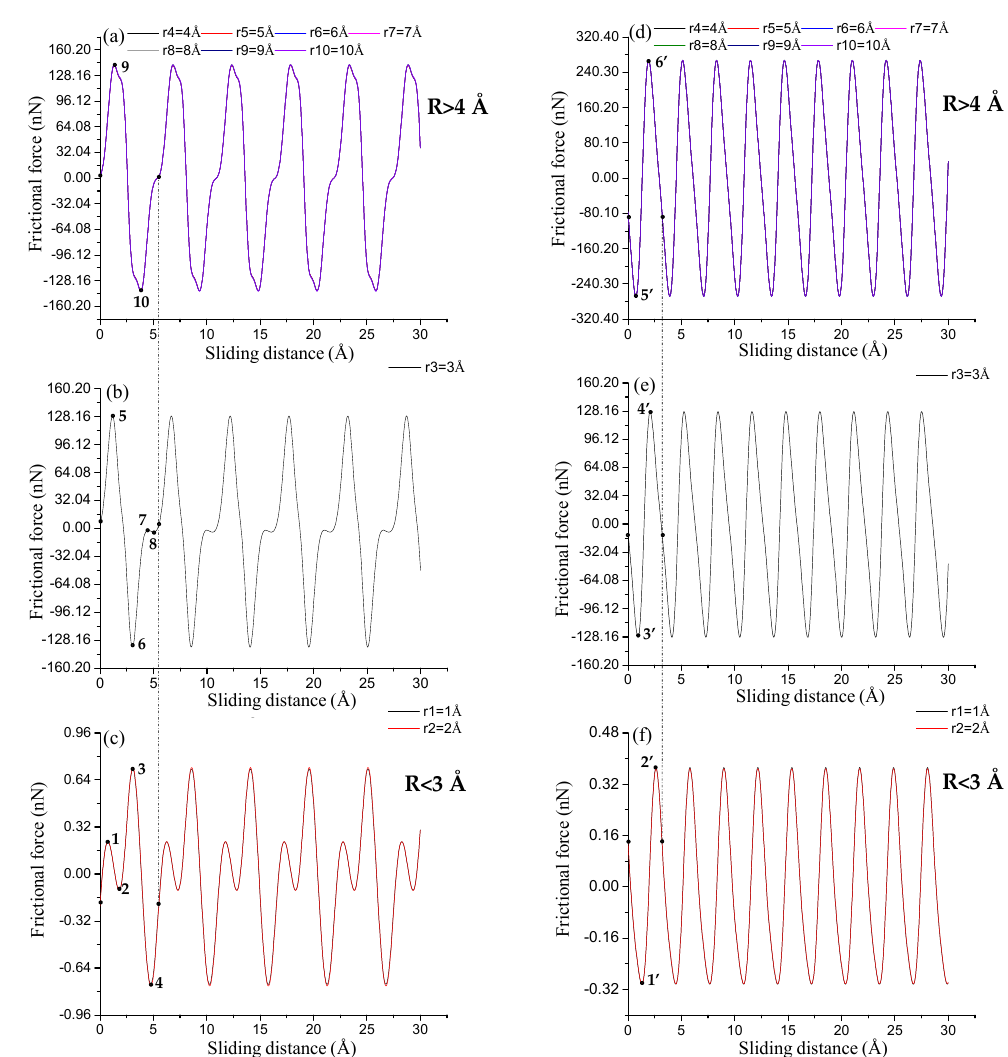
Figure 3. Frictional force–sliding distance curves for sliding paths along ( a – c ) AC orientation and ( d – f ) ZZ orientation of SLMoS 2 for tips of 1 to 10 Å radii. Periodicities for each sliding path are almost constant for tips of all radii (1 to 10 Å radii), and are ~5.48 Å ( a – c ) for the AC orientation and 3.16 Å ( d – f ) for the ZZ orientation. The periodicities are the same as the lattice constants of SLMoS 2 . The r1, r2, r3, r4, r5, r6, r7, r8, r9 and r10 are defined as the tips with radii of 1, 2, 3, 4, 5, 6, 7, 8, 9 and 10 Å, respectively . The curves in Figure 3a,c,d,f look like a single curve, but they are the overlap of multiple curves, and the displayed curve is the dark colored curve (such as purple curves for Figure 3a,d, and red curves for Figure 3c,f).